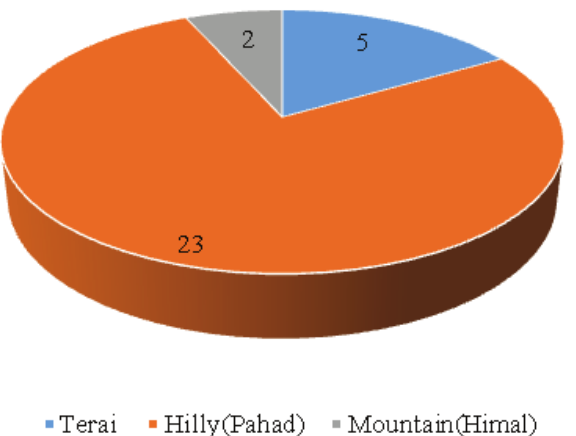
Figure 2: Patient distribution according to geographical